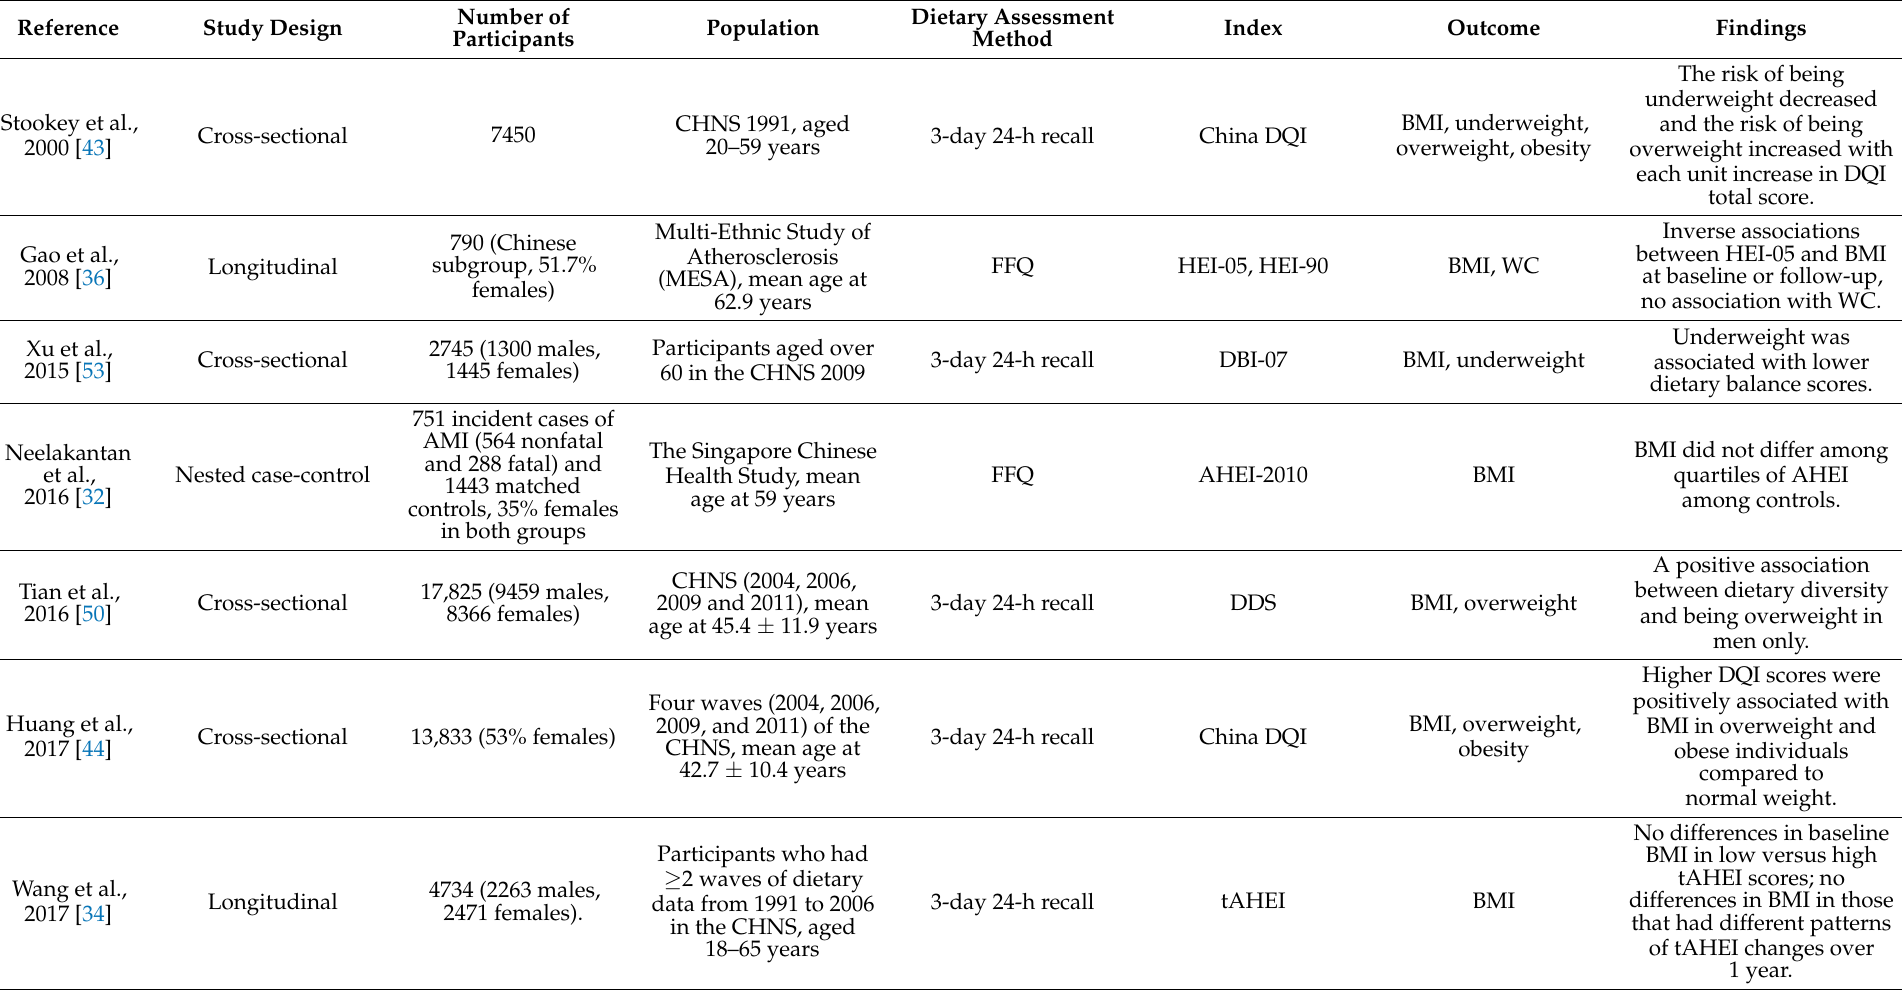
Table 1. Summary of the characteristics of the included